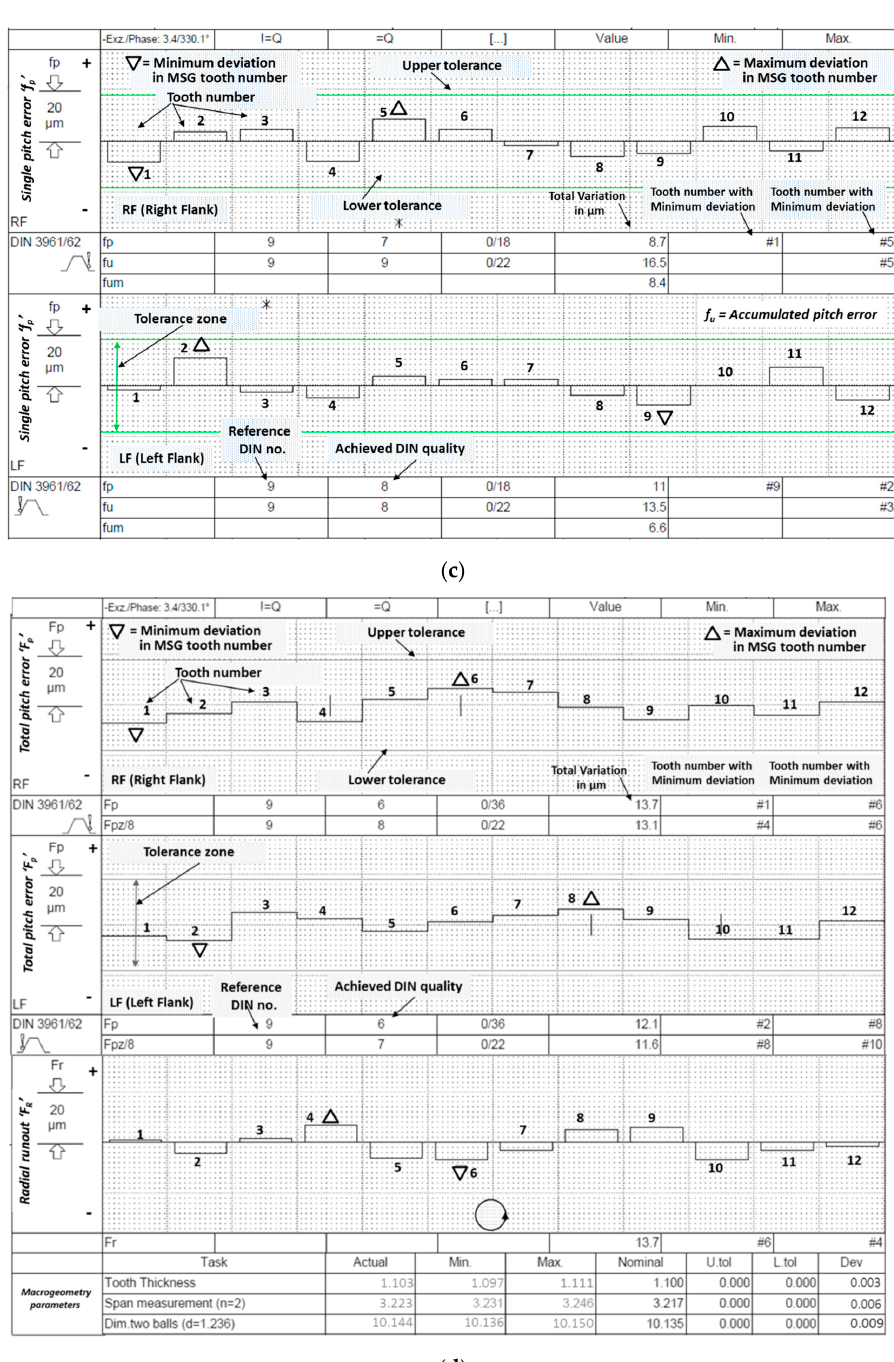
Figure 8. Metrological inspection report of best finish miniature gear manufactured by WTEM at optimized parameters: ( a ) total profile error ‘ F a ’; ( b ) helix or lead error ‘ H ß ’; ( c ) single pitch error ‘ f p ’ and adjacent pitch error ‘ f u ’; and ( d ) total cumulative pitch error ‘ F p ’ and radial runout ‘ F r ’.